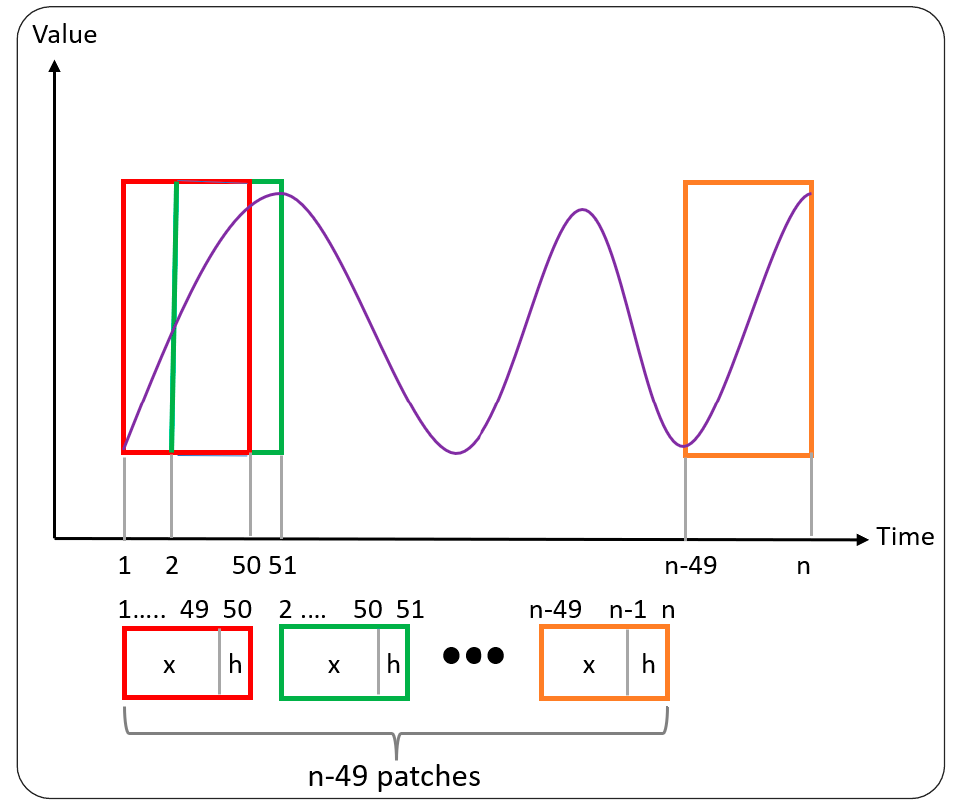
Figure 1. An illustration to the sliding window input concept.